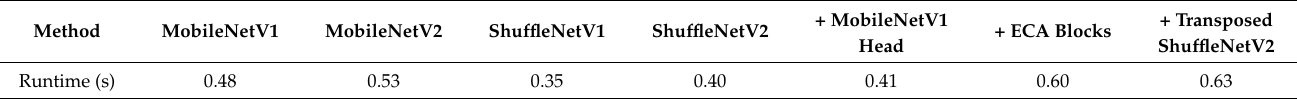
Table 6. Inference time of all models in the network design pipeline. We use one NVIDIA RTX 3090 for all implementations. “+ MobileNetV1” replaces the 3 DConv 0 with the 3D MobileNetV1 module. “+ ECA block” add 3D ECA block on all 3D kernels. “+ Transposed ShuffleNetV2” replaces the 3 DStack 5_ x and 3 DStack 6_ x deconvolution layers with 3D Transposed ECA-ShuffleNetV2.